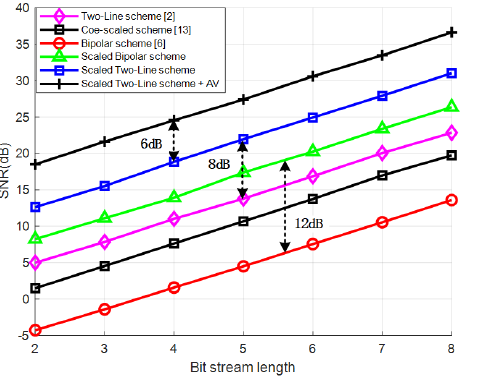
Figure 10. SNR performance evaluation on stochastic logic-based multiplication unit.